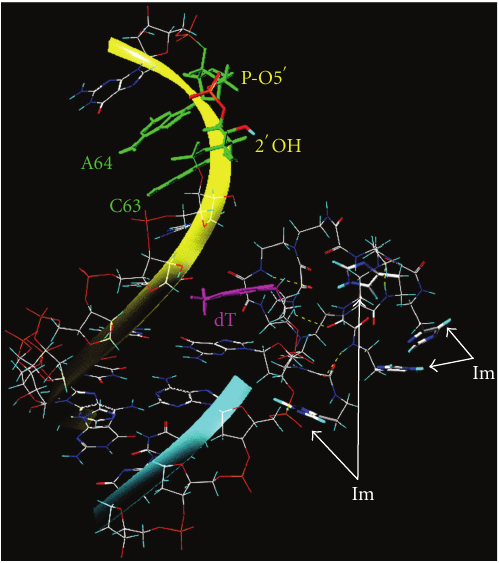
Figure 7: A fragment showing one possible conformation for the hybrid complex between artificial ribonuclease B-Im(4/2b) and tRNA. In this final conformation, F5-Im(4/2b), the imidazole cleav- ing groups are located distant from the target sequence. The dT linker fragment (magenta) shows interaction with the dG 1 residue in a semi-stacking interaction, possibly restricting the conforma- tional freedom of this molecule. Hydrogen bonds are shown in